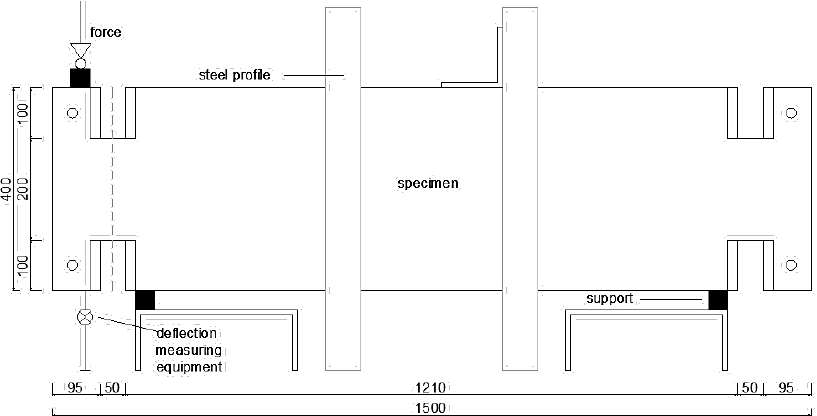
Figure 4. Experimental design (dimensions in mm).